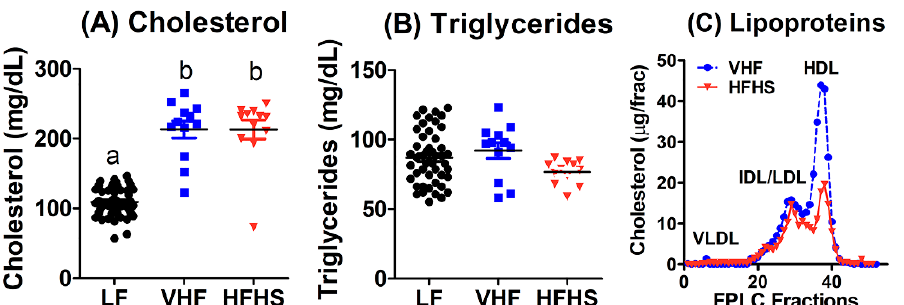
Figure 2. Diet effects on plasma lipid and lipoproteins. Male C57BL/6J mice were fed low fat (LF), very high fat (VHF), or moderately high fat with excess sucrose (HFHS) diets for 12 weeks. Fasting plasma cholesterol ( A ) and triglyceride ( B ) levels were determined from 49 LF-fed mice and 12 VHF-fed and 12 HFHS-fed mice. Data groups with letter a are significantly different from data groups with letter b at p < 0.01 (1-way ANOVA with Bonferroni post hoc analysis). ( C ) Representative plasma lipoprotein profile determined after fast-performance liquid chromatography (FPLC) separation of plasma samples from VHF- and HFHS-fed mice.